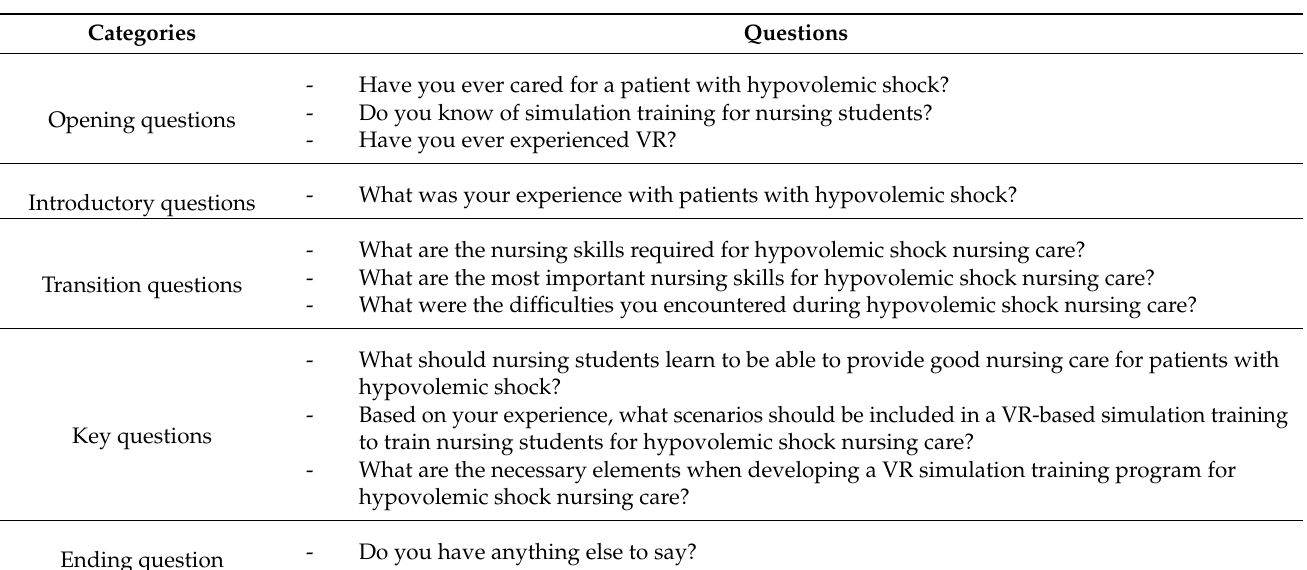
Table 2. Questions for the focus group